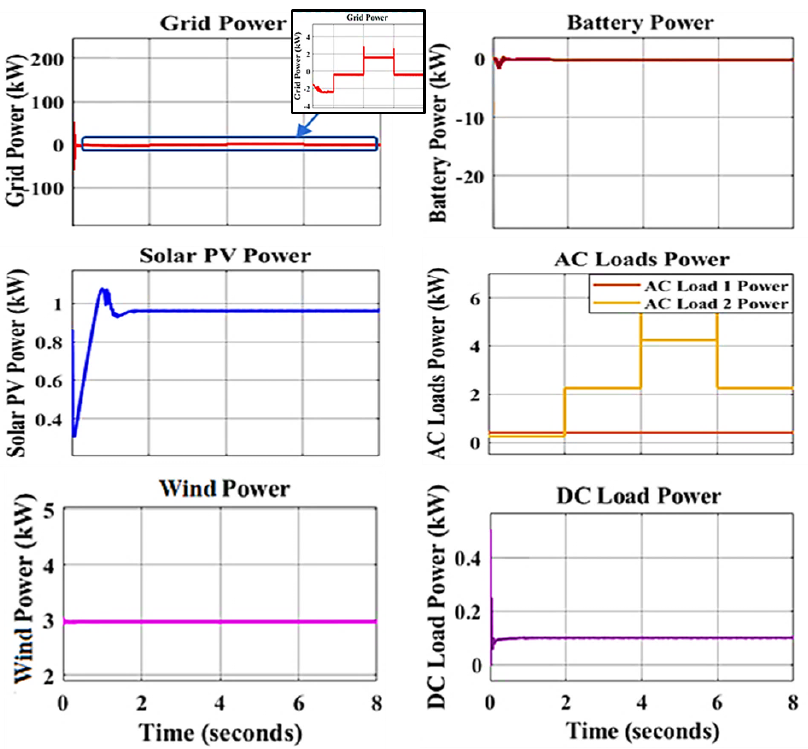
Figure 13. The power of generation resources, main grid, and AC and DC loads under load varia- tion.